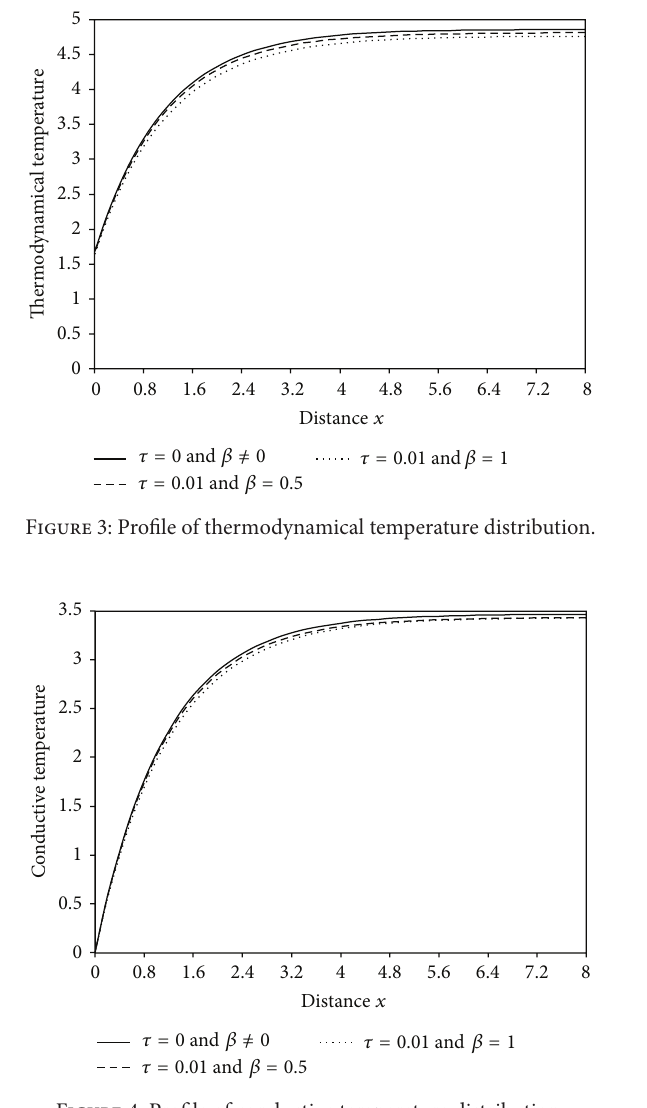
Figure 4: Profile of conductive temperature distribution.